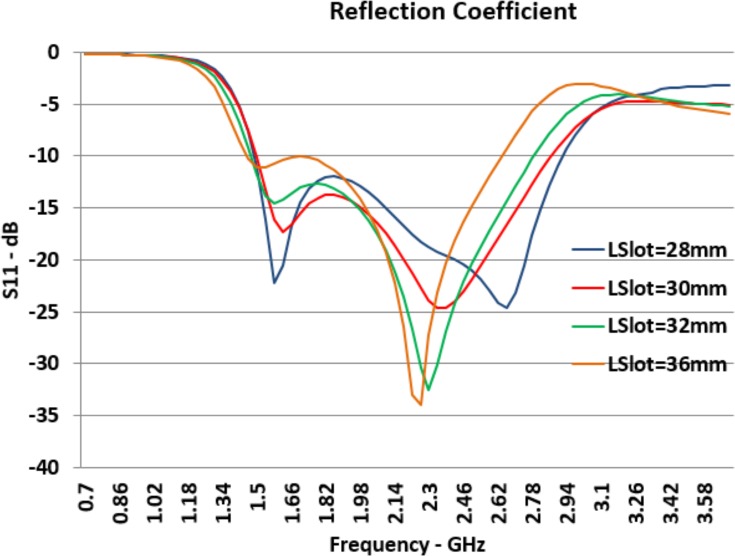
Effect of LSlot Changes on Reflection Coefficient (S11).